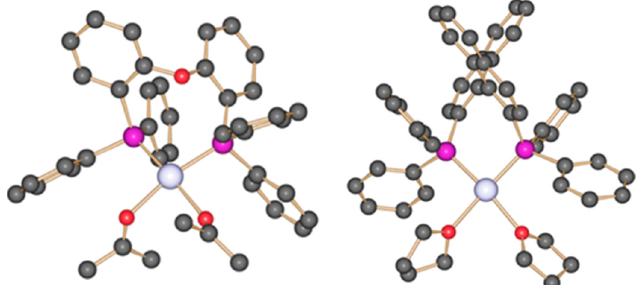
Figure 9. Molecular structure of the cations of the solvent complexes [Rh(DPEPhos)(acetone) 2 ] + and [Rh(BINAP)(THF) 2 ] + . Hydrogen atoms are omitted for clarity.